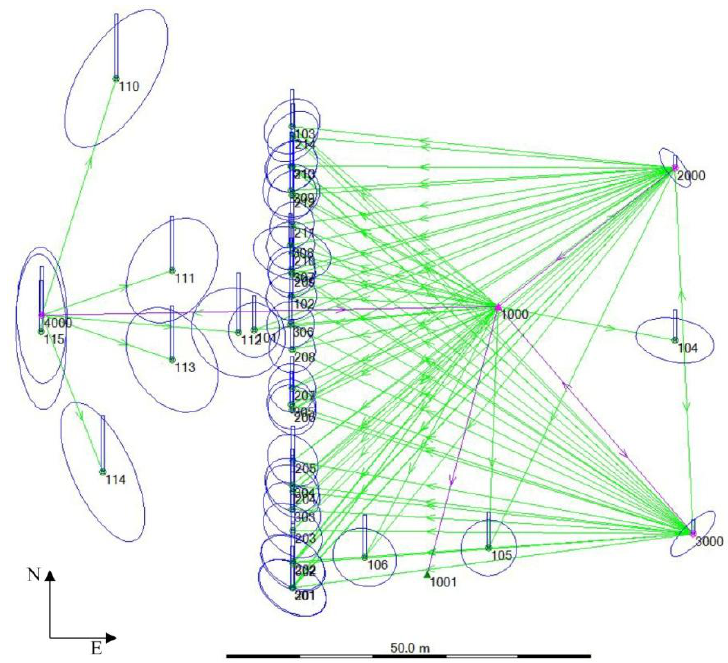
Figure 14. The October 2011 topographic network after the roto-translation of all points in a new 3D coordinate system. The magnification factor of the error ellipses compared with the network is equal to 5,000.